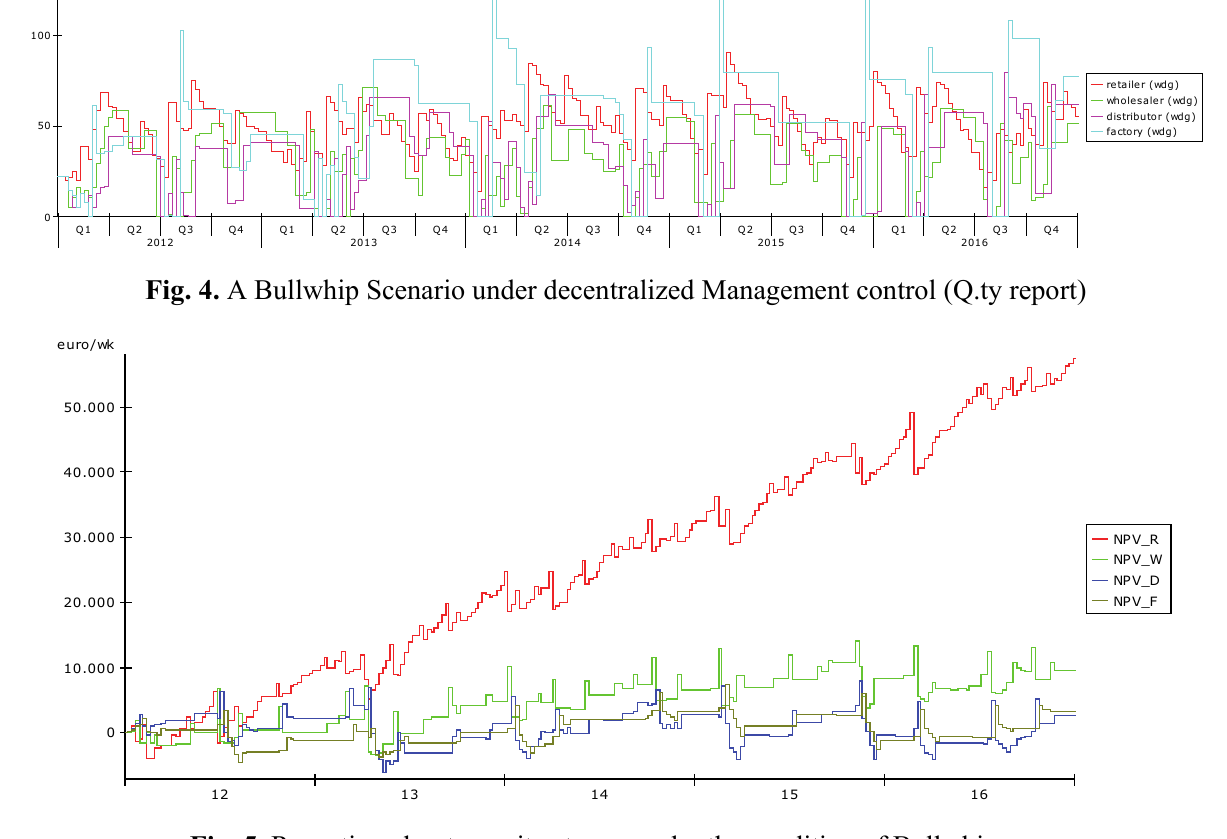
Fig. 5. Reporting about annuity stream under the condition of Bullwhip